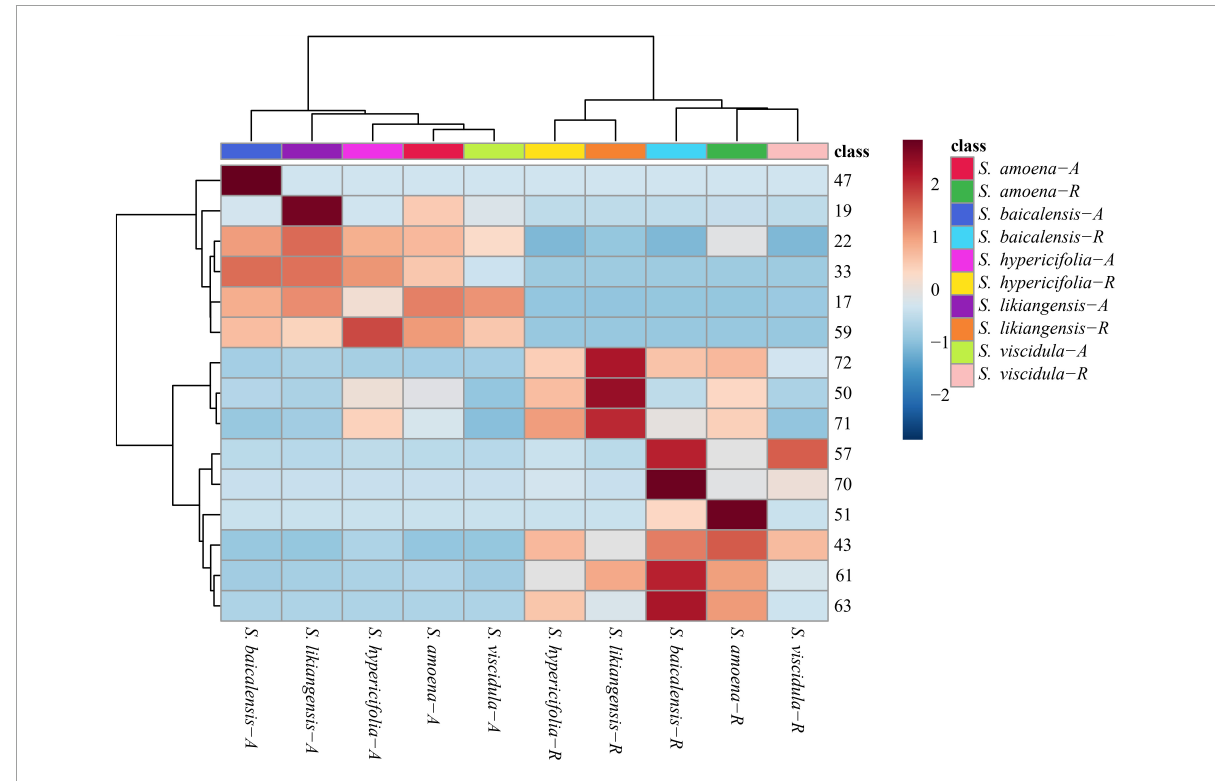
FIGURE4 Clustering heatmap of 15 compounds in different parts of five Scutellaria species (the number of analytes corresponds to Table 1 ; -A: aerial parts, -R: roots).